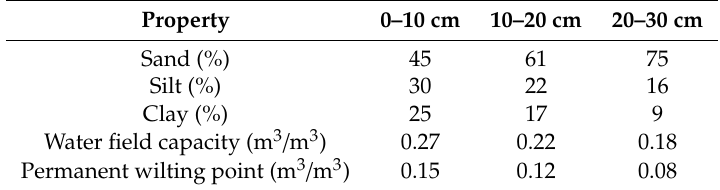
Table 1. Main characteristics of the soil in the experimental plot at di ff erent